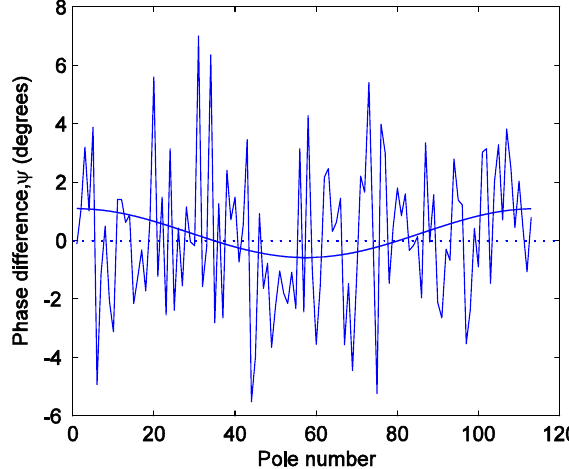
FIG. 4. Phase differences corresponding to Figs. 2 and 3 (red curves).